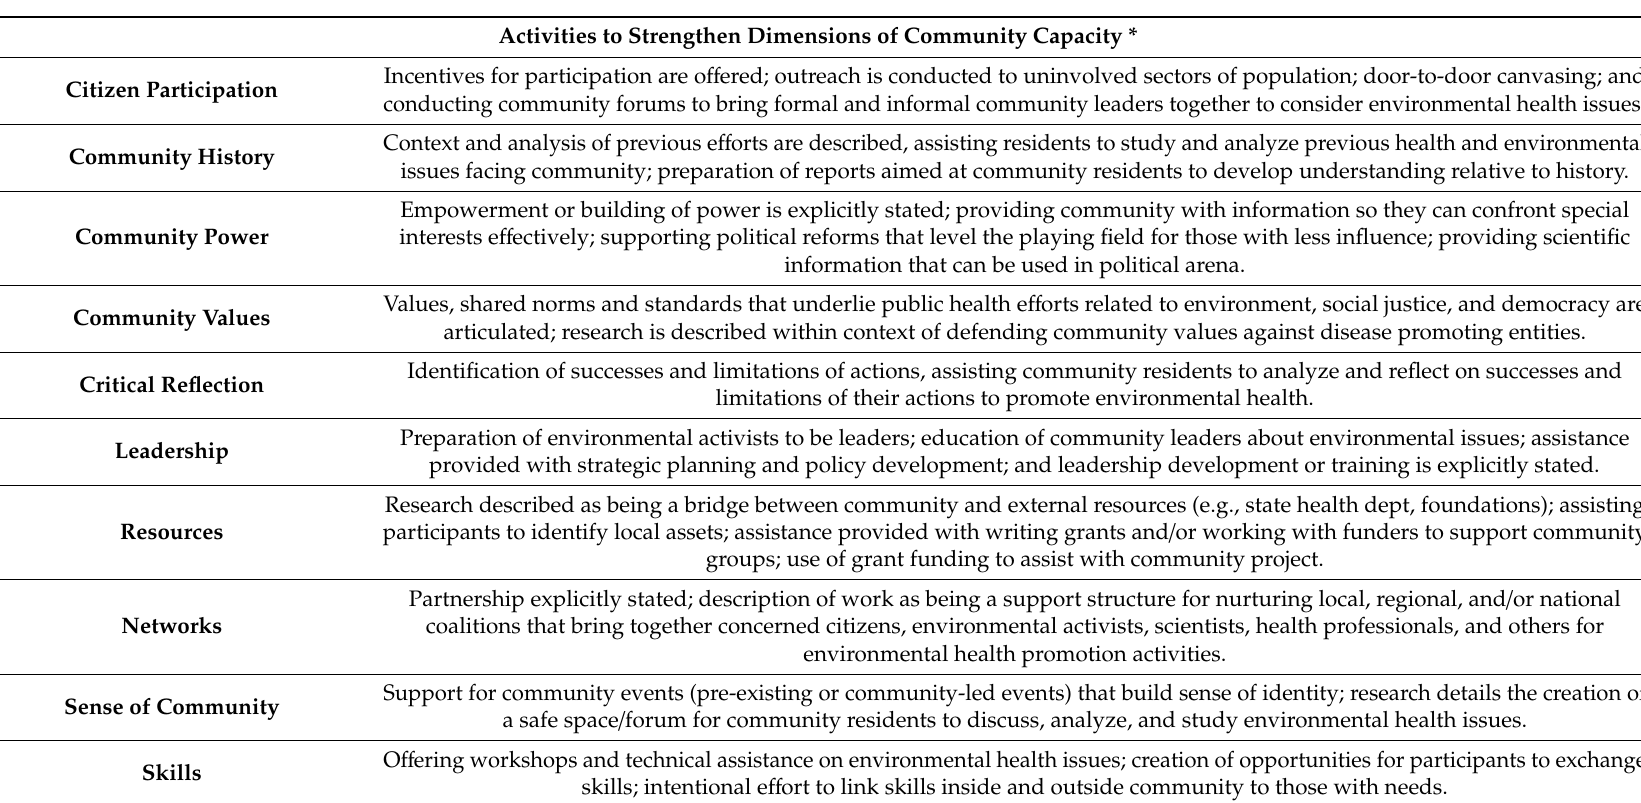
Table 2. Activities to strengthen dimensions of community